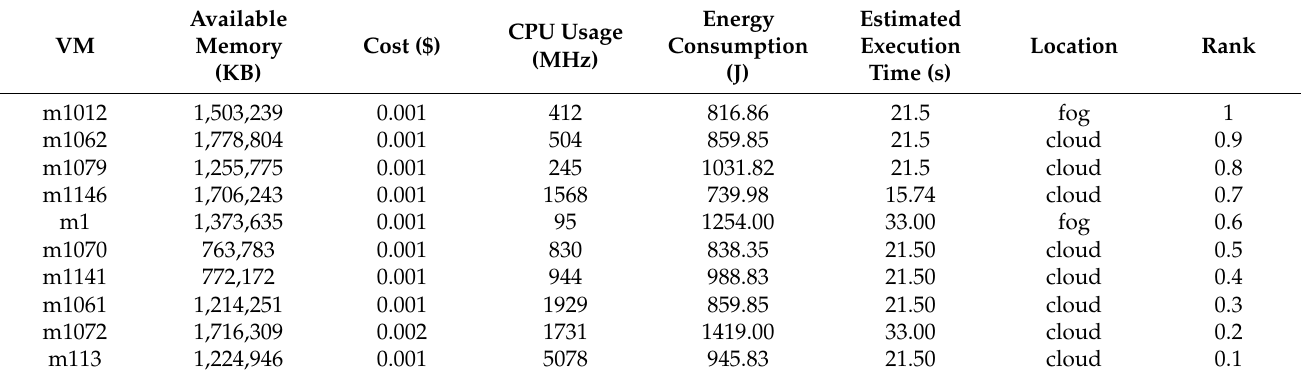
Table 9. Optimization results Task 108145 with weights: w − MA = 0.2, w + = 0.2, w − = w − R CPU